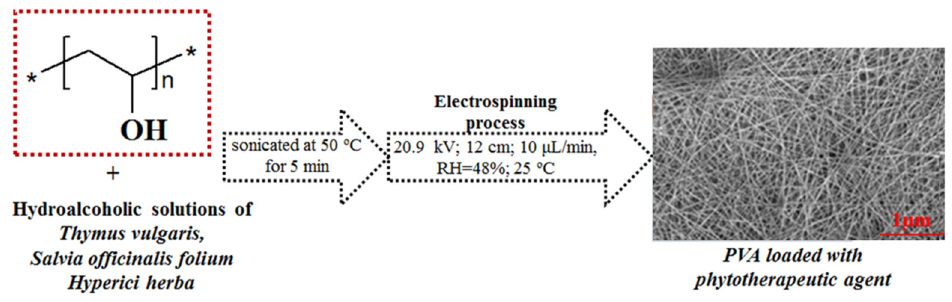
Figure 1. Schematic representation of the preparation of electrospun PVA membranes loaded with phytotherapeutic agents.